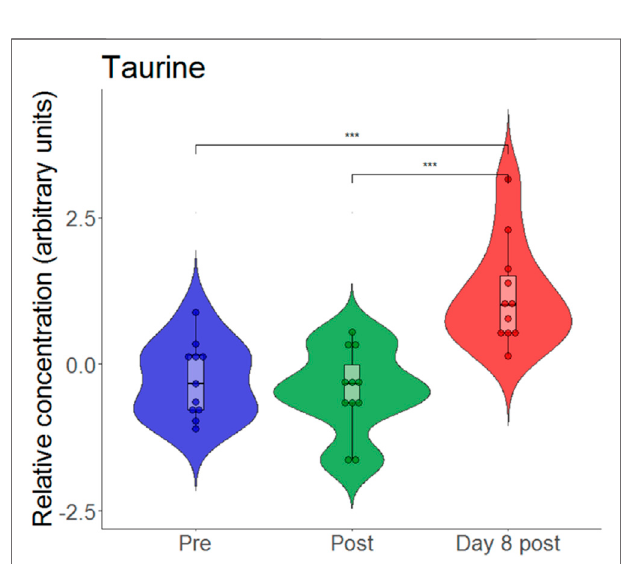
FIGURE 8 | Violin plots with relative blood metabolite concentrations at baseline before (pre), immediately after (post) and on day 8 after (day 8 post) the eccentric exercise performed in hypoxia. *** p ≤